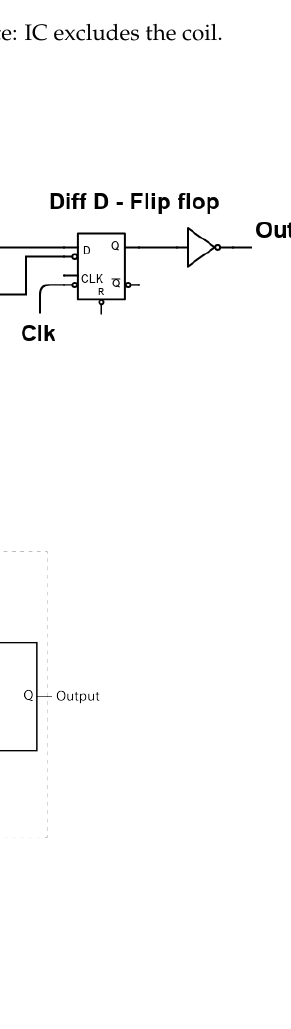
Figure 7. Schematic of non-coherent digital